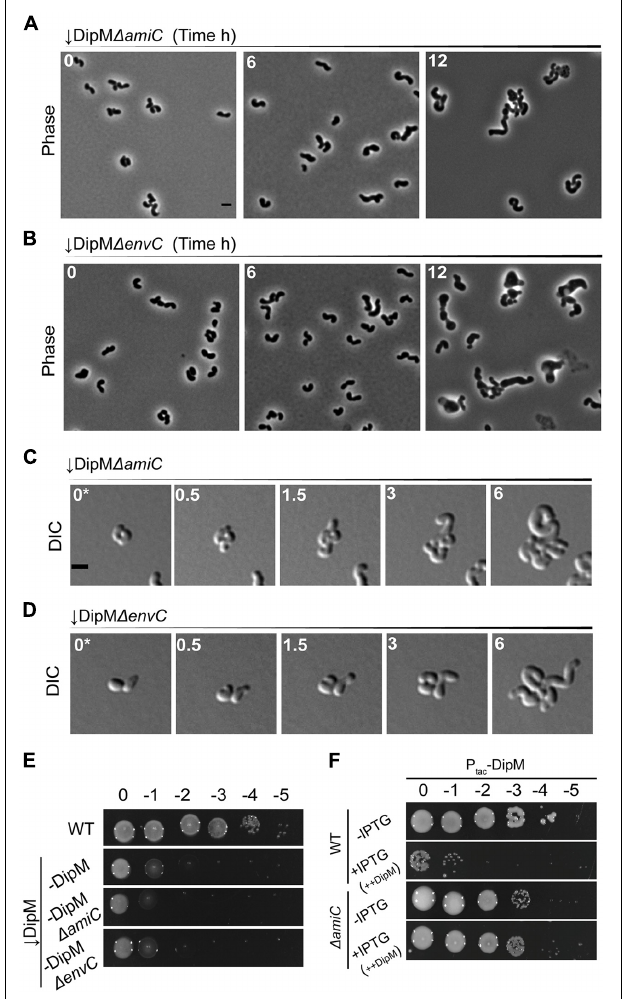
FIGURE 6 | DipM likely functions in pathways that are distinct from, but overlap with, the EnvC–AmiC pathway. Phase-contrast microscopy of (A) ↓ DipM (cid:49) amiC or (B) ↓ DipM (cid:49) envC depleted for exactly 0, 6, and 12 h. (C) DIC time-lapse of ↓ DipM (cid:49) amiC or (D) ↓ DipM (cid:49) envC pre-depleted for 6 h in liquid to avoid overcrowding caused by division events prior to sufficient DipM depletion. (E) Spot viability assays of WT, DipM depleted (–DipM), –DipM (cid:49) amiC , and –DipM (cid:49) envC cells. (F) Cell viability of WT and (cid:49) amiC cells containing empty plasmid (Ptac-Empty) or overproducing DipM (+IPTG, ++DipM). ++DipM indicates that DipM is being overproduced. To better define the dipM overexpression phenotype in WT and (cid:49) amiC , spotting assays